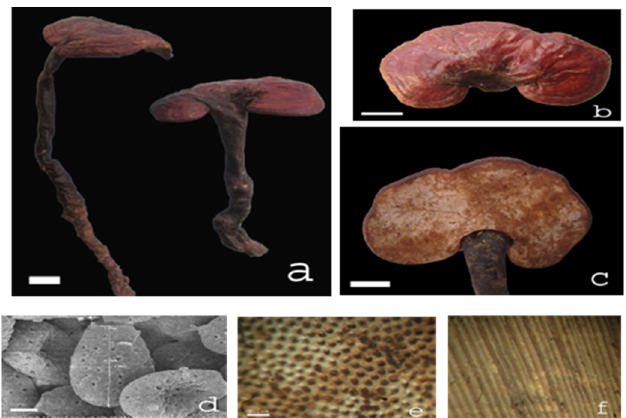
Figure 5. Ganoderma sample (G6, Ganoderma lucidum (Curtis) P. Karst. 1881), known locally as Natural Green Lim mushroom (N ấ m Lim Xanh). Notes: ( a , b , c ) Fruit body, ( d ) spores (SEM), ( e ) planned layer, and ( f ) mushroom tube. Natural shape ruler = 2 cm, microscopic ruler = 2 µm, laminar ruler = 0.5 mm.